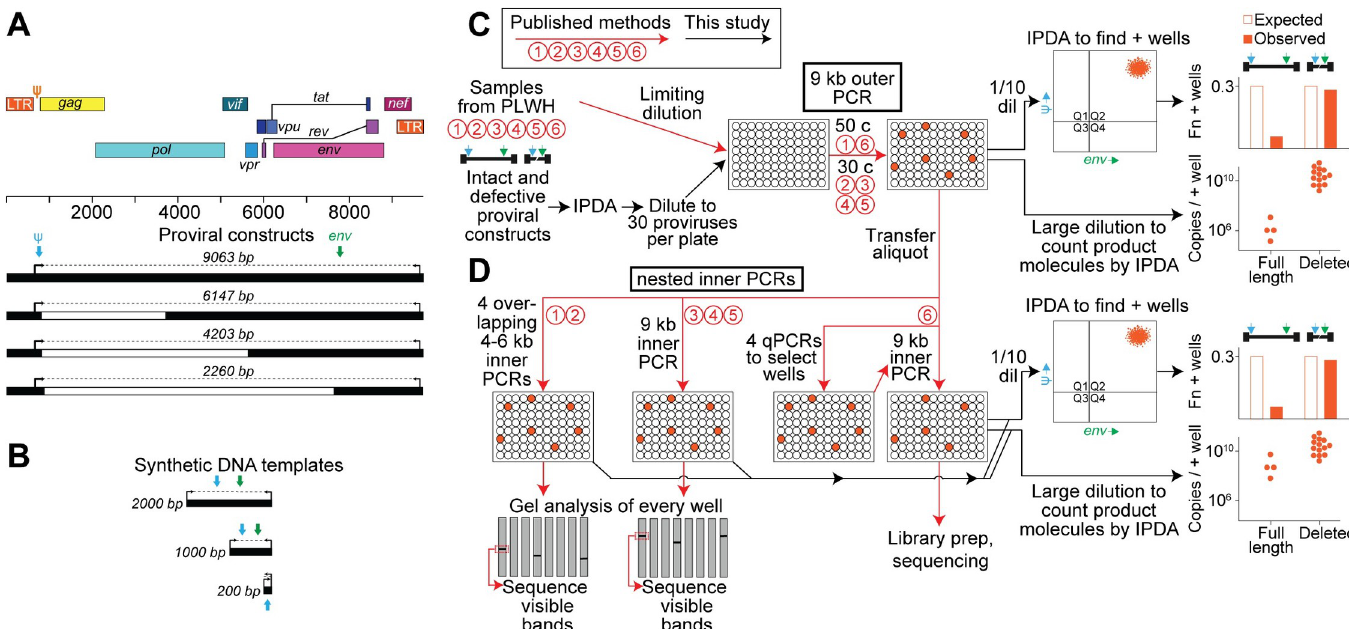
Fig 2. Quantitative analysis of nFGS methods. ( A ) Proviral constructs used to evaluate efficiency of nFGS methods. NL4-3-derived proviral constructs are shown in relation to the HIV-1 proviral map. Numbers in italics indicate the size of the amplicons obtained with the nFGS outer primers (black arrows). Deleted regions are shown in white. Positions of the IPDA ψ (blue arrows) and env (green arrows) amplicons are indicated. ( B ) Synthetic double stranded DNA templates used to evaluate efficiency of nFGS methods. ( C,D ) Experimental protocol. Published methods (red arrows) and our quantitative analysis of those methods (black arrows) are summarized in the flow diagram. Numbers in red circles refer to individual methods described in S1 Table. Analysis of the long-distance outer PCR step common to all nFGS methods is described in Panel C. Methods 1–6 all use the same outer PCR primers to generate a 9064 bp amplicon. Outer PCR wells were screened by IPDA analysis of a 1/10 dilution of the PCR products. The fraction of wells giving exponential amplification (see Fig 1 ) was determined, and then a large dilution of each positive well was analyzed by IPDA to count individual product molecules. The nested inner PCRs used in each nFGS method were analyzed as described in Panel D . For Method 6, a 9 kb inner PCR is run only for wells that have more than one positive nested subgenomic qPCR. Methods 3 and 5 are very similar to Method 4 but use a different polymerase and/or cycle number (see S1 Table for details) and were not tested here.